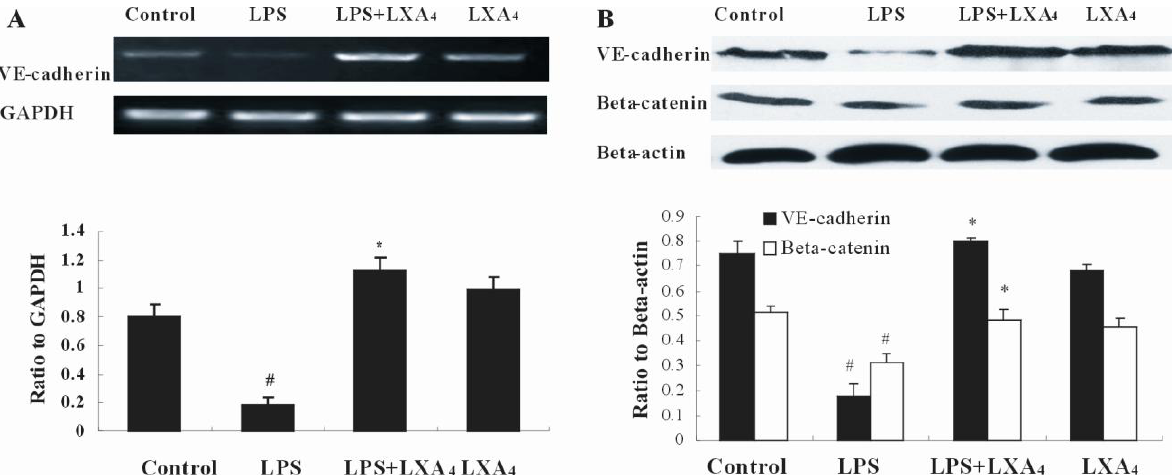
FIGURE 3. The expression of VE-cadherin and β-catenin in HUVECs under different conditions. (A) Representative RT-PCR for VE-cadherin is shown. GAPDH served as internal control. Bar graphs indicate means ± SEM from at least three independent experiments. (B) Representative Western blots for VE-cadherin and β-catenin are shown. Beta-actin served as internal control. Bar graphs indicate means ± SEM from at least three independent experiments; # p < 0.05 compared to control cells; * p < 0.05 compared to cells treated by LPS alone.